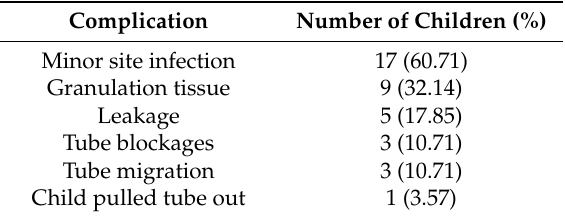
Table 3. Complications of gastrostomy tube feeding within one year of gastrostomy